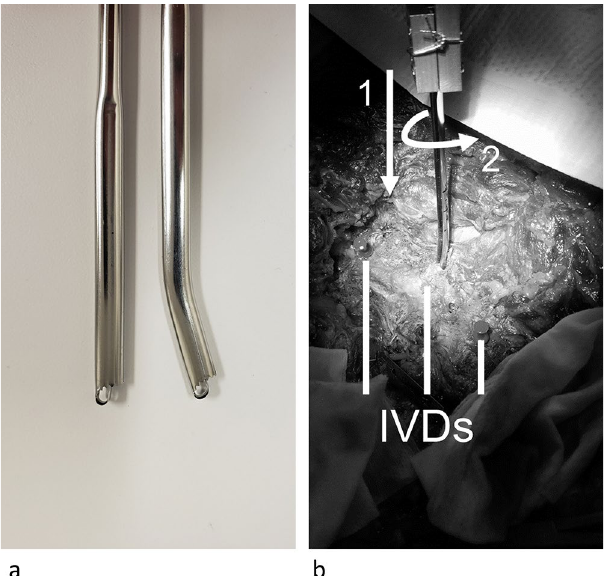
Figure 1. Concorde Clear tools used in the test. ( a ) shows the straightened tool (left) used in the linear test as well as the normal bent tool (right) used in the torsional test. ( b ) shows the test setup and motion, where the tool is inserted (1) into the intervertebral disc (IVD) and twisted (2). The linear test involved motions 1 and 2, while the torsional test was only motion 2. IVDs are